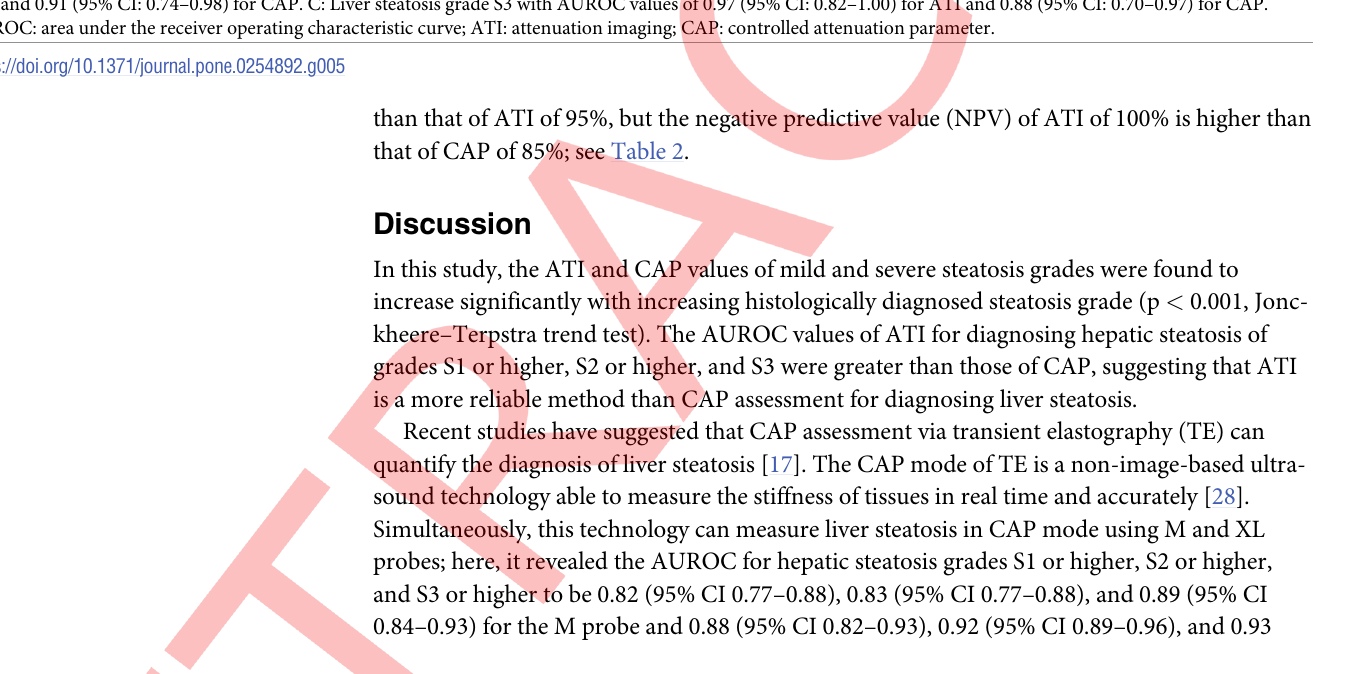
Table 2. CAP and ATI values for diagnosing liver steatosis. Model Steatosis stage